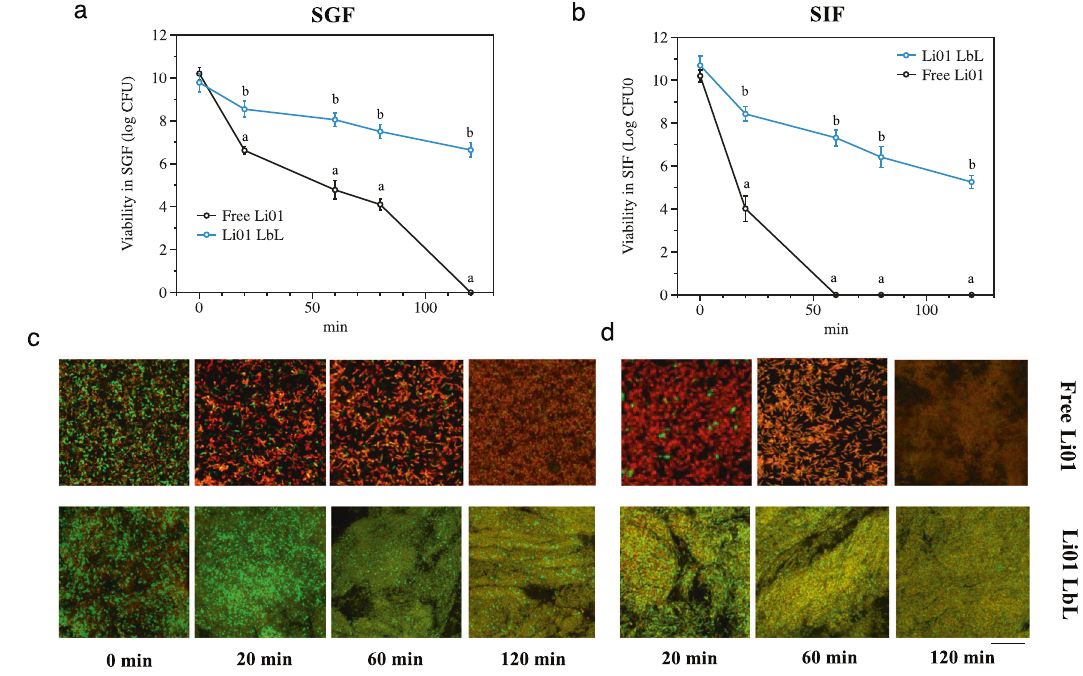
Fig. 2 Viability of probiotics during GI transit. Viability count of non-encapsulated (Free) Li01 and LbL Li01 in simulated gastric fl uid (SGF) ( a ) and simulated intestinal fl uid (SIF) ( b ) after incubation for 0, 20, 60, 80, and 120 min. A small portion of bacterial samples in both SGF ( c ) and SIF ( d ) collected at the time 0, 20, 60, and 120 min in both were stained and visualized by using confocal microscopy ( c , d ). Scale bar at lower right represents 50 μ m. Data are presented by mean ± SD, n = 6, different letters indicate signi fi cant different between groups (P < an indicator of the integrity of epithelium barrier, was also measured (Fig. 3a). After being exposed to either non- encapsulated Li01 or LbL Li01 for 1 h, the TEER of Caco-2 cell monolayers was observed to increase. Compared to cells exposed to non-encapsulated Li01, the increased TEER levels of monolayers treated with LbL Li01 were signi fi cantly higher; 16.75 ± 6.66% versus 5.14 ± 0% (P < 0.05). The amount of bacteria adhered on the Caco-2 cell monolayer was measured as shown in Fig. 3b. As was expected, the fl uorescent intensity was doubled, indicating a higher number of LbL Li01 cells adhere to the monolayer as compared to non-encapsulated Li01 cells. Figure 3c displayed the microstructures of the bacteria attached to the monolayers, which con fi rmed that Li01 cells attached to the microvilli of the Caco-2 monolayer. To determine the dynamics of probiotic GI transit and colonization in vivo, a germ-free rat model was used. The rats were fed through gavage with free Li01 or LbL Li01. As shown in Fig. 3d, among rats fed with free Li01, the probiotics were fi rst detectable in the feces 8 h after oral administration, whereas probiotics were detectable fi rst after 12 h in feces from rats fed with LbL Li01. Since LbL Li01 exhibits better mucoadhesive effect, their retention time in the intestine was likely longer than free Li01. Among rats fed with LbL Li01, the fecal concentration of Li01 quickly increased to 9 log CFU/g after 24 h. This level remained stable with only mild fl uctuations during the following days of observation. Among rats fed with free Li01, the fecal concentra- tion of Li01 increased to 7 log CFU/g after 12 h but similarly reached a level of ~9 log CFU/g 48 h after gavage. These results also indicate that LbL Li01 seems more ef fi cient in colonizing the intestine compared to free Li01 cells. Research has demonstrated that alginate and chitosan have mucoadhesive properties and can adhere to the mucus to increase residence time, thus facilitating colonization of probio- tics in the intestine 37 . Mucus is a dense network of macro- molecular components and their major constituents are heavily